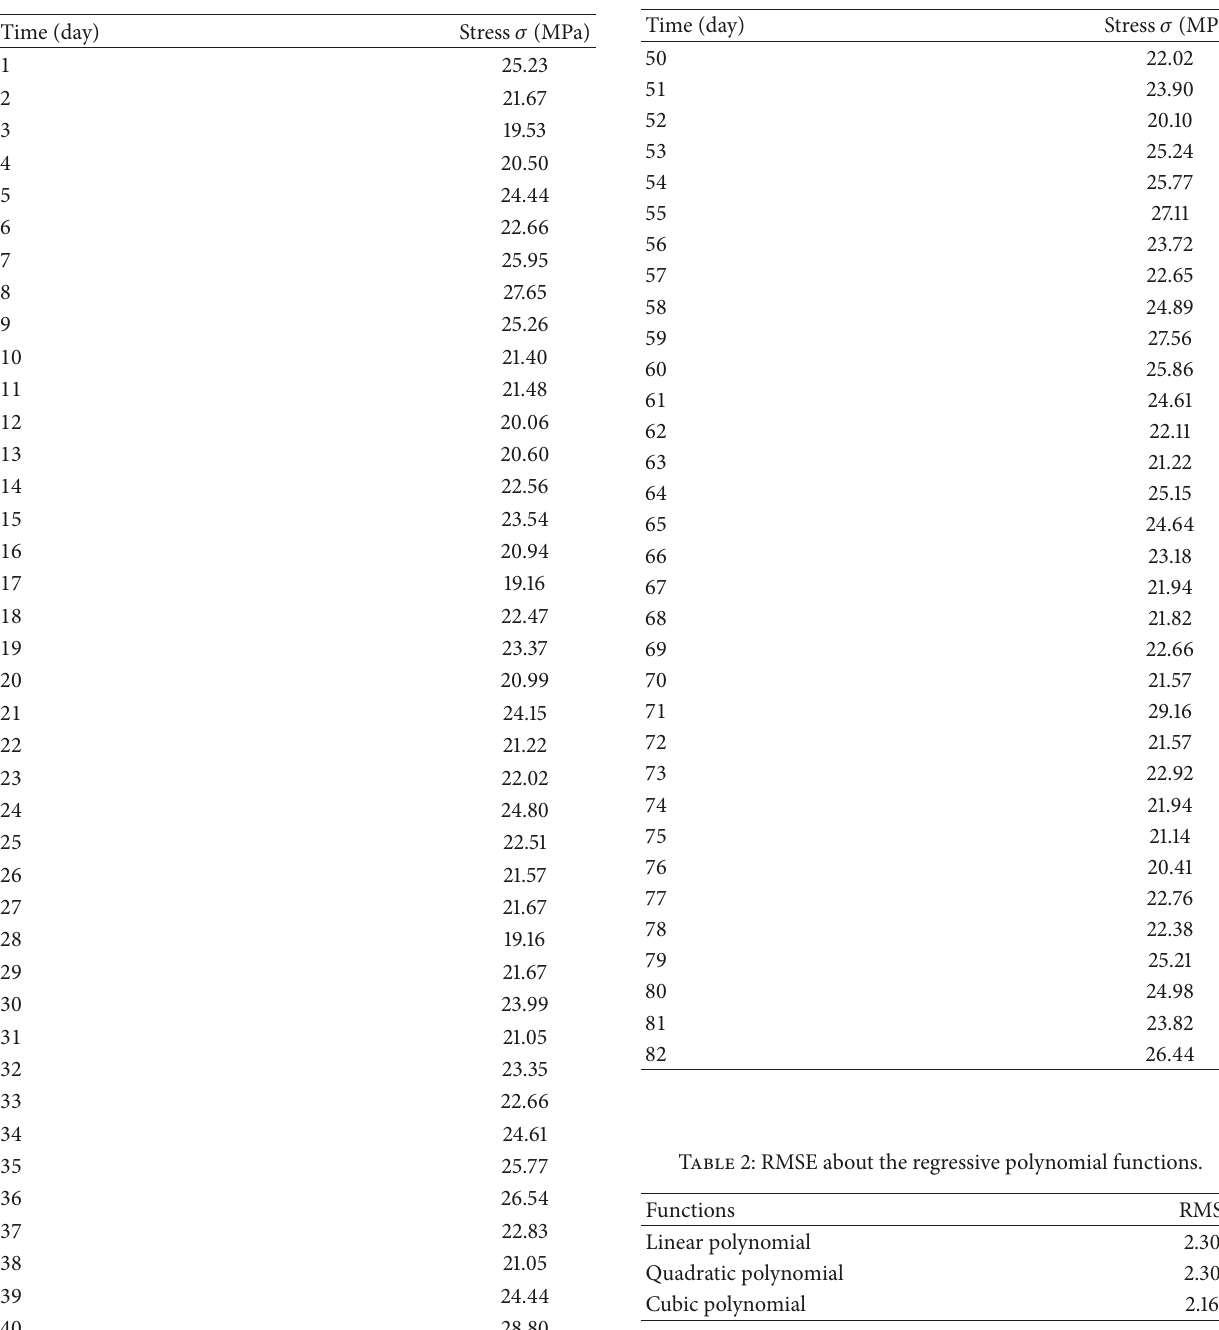
Table 1: Dynamic monitored extreme stresses [9, 14].